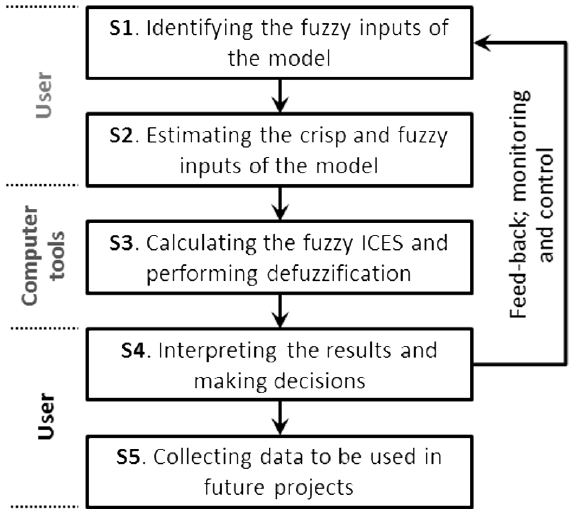
Fig. 3. Fuzzy-MIVES-EHEm method